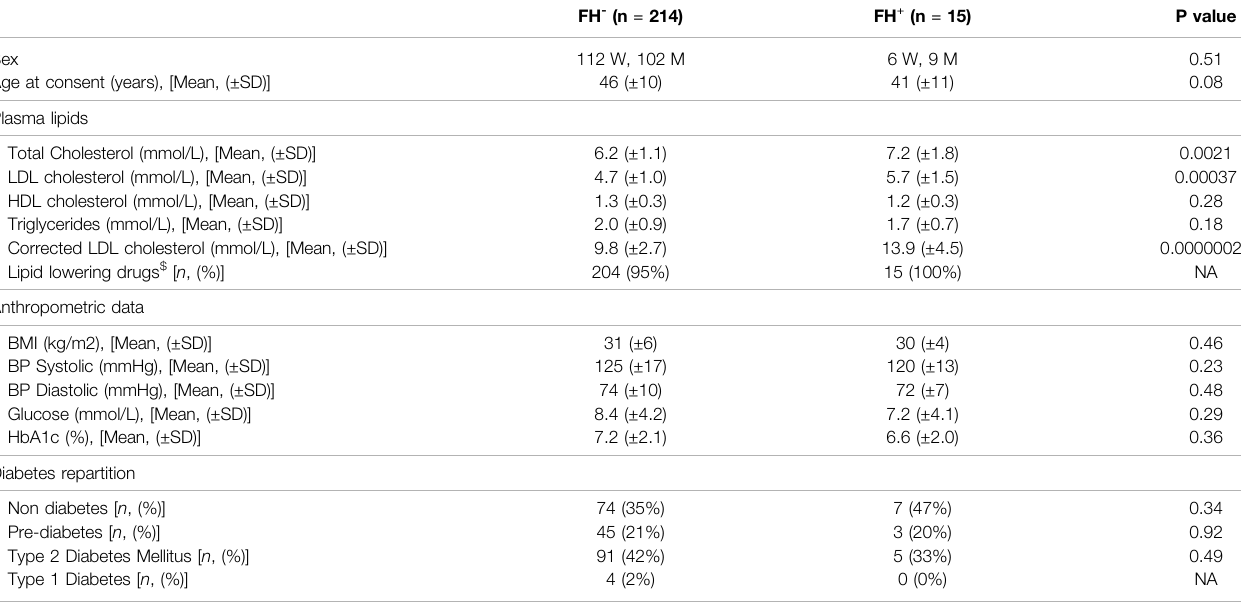
TABLE 3 | Differences between participants with (FH + ) and without (FH - ) rare causal variants in LDLR , APOB , and PCSK9